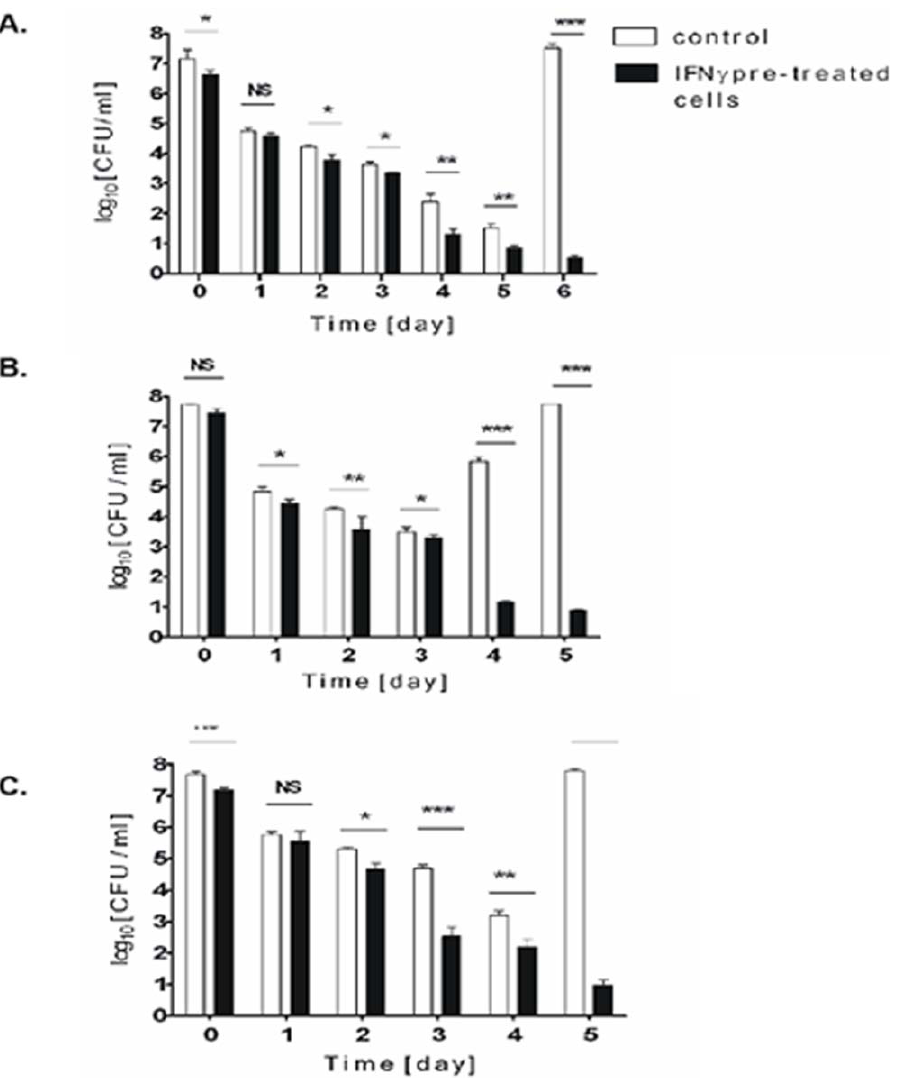
Figure 4. Macrophages stimulated with interferon- c kill engulfed S.aureusstrains: Newman (A), ATCC 25923 (B), and COL (C) more efficiently than non-stimulated cells. Cells were stimulated with recombinant human IFN c overnight at concentrations equivalent to human therapeutic doses (100 U ml 2 1 ), and then allowed to phagocytose three different strains of S. aureus for 2 h. Infected cultures were processed as described in the legend for Fig. 3A and live bacteria in the whole cultures (CFU) were enumerated up to 14 days postphagocytosis. Since at the longer timepoints no bacterial growth was detected (CFU=0) these points were not presented on the graph. The data shown is representative of at least three separate experiments, performed in triplicate, using hMDM derived from different donors. Bars represent mean CFU value 6 SD. *, p , 0.05; **, p , 0.01; ***, p , 0.001. NS-not significant.